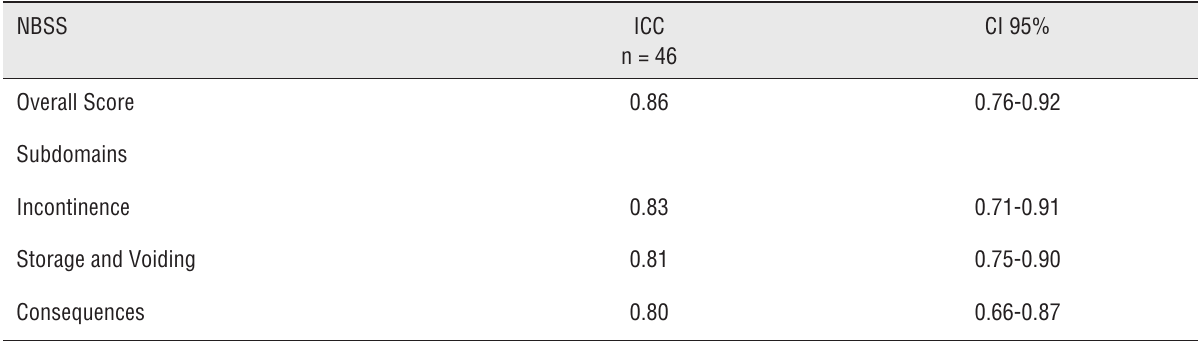
Table 2 - Reproducibility and internal consistency of NBSS.